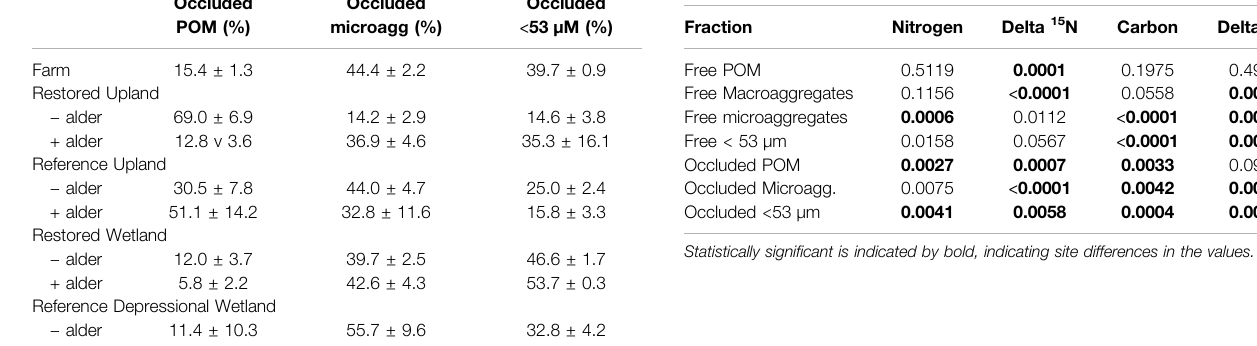
TABLE 5| Statistical p values averaged acrossnine sitesinvestigatedinthisstudy for concentrations of nitrogen and carbon and natural abundance of stable isotopes in different fractions of hierarchical